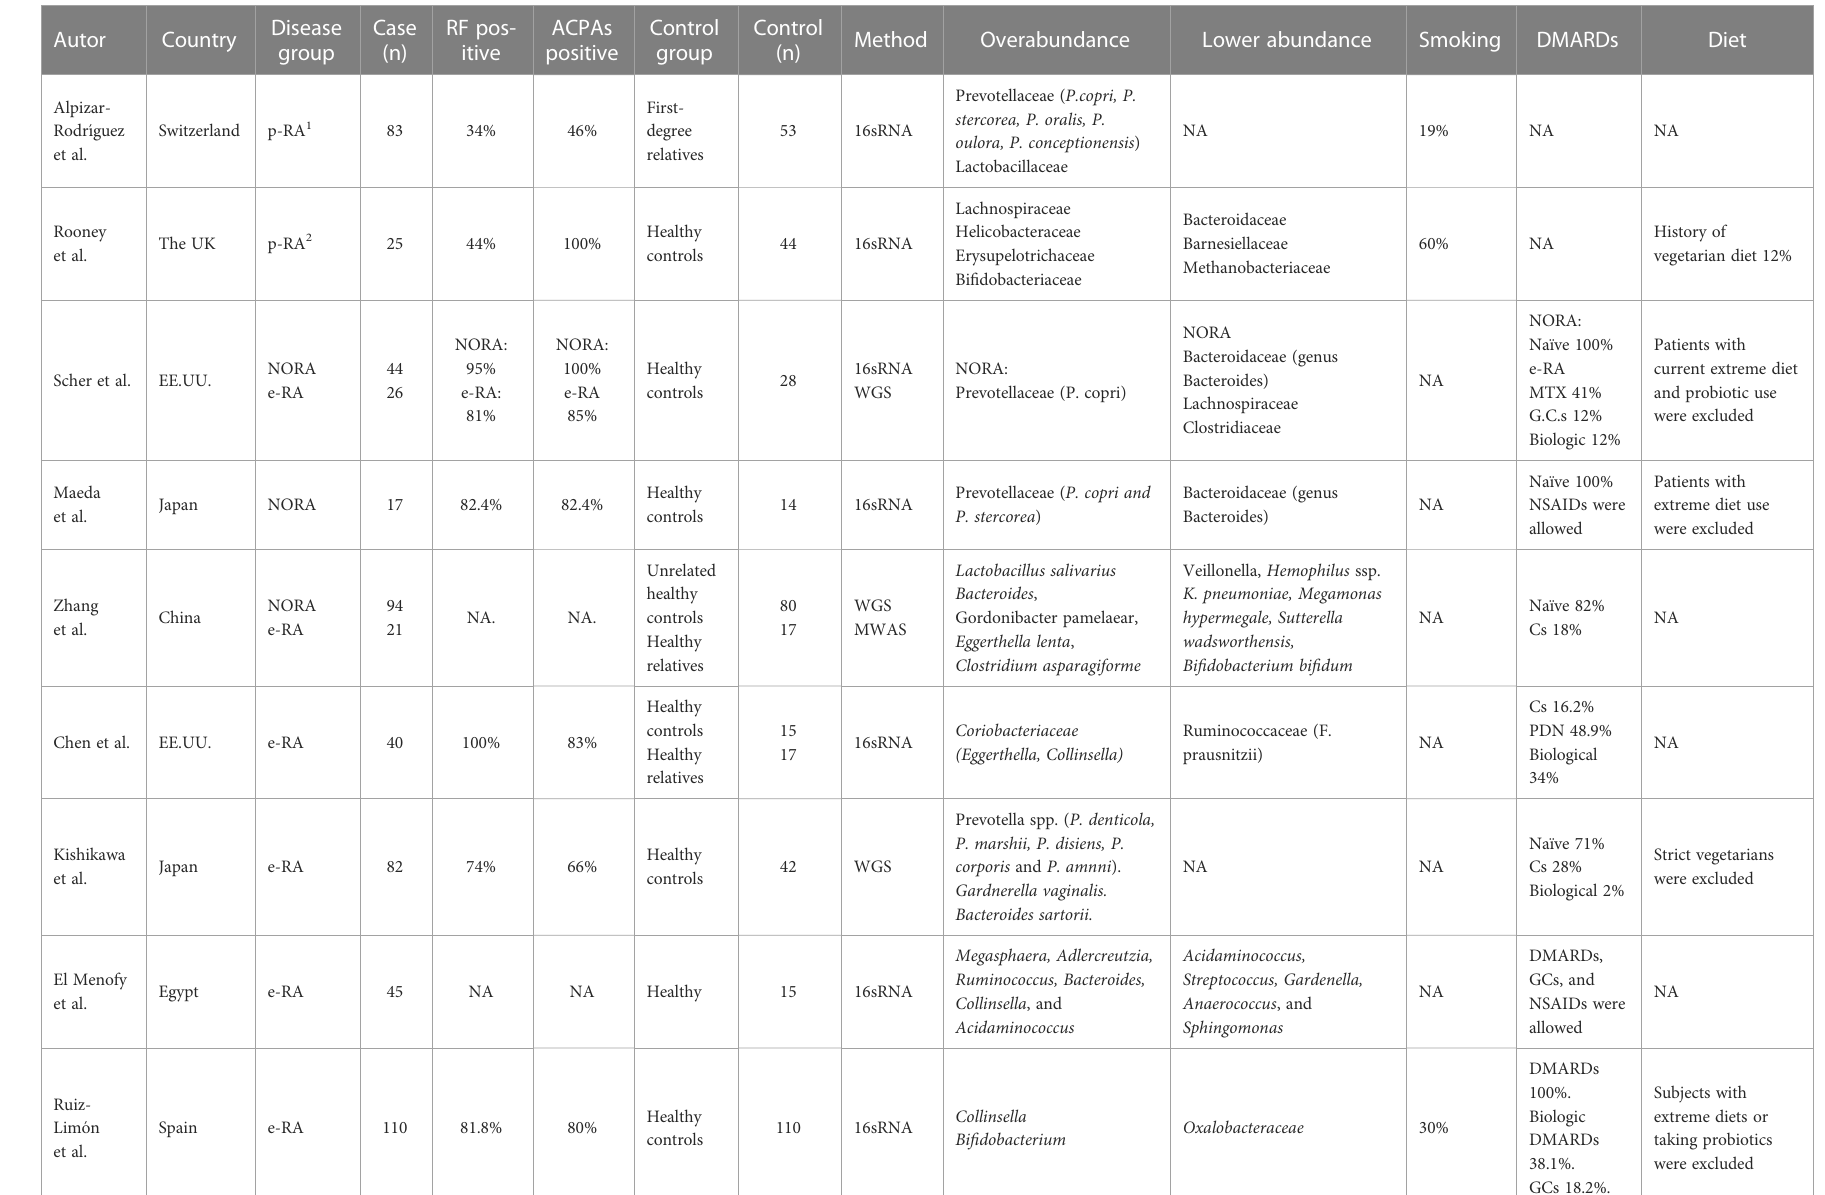
TABLE 1 Summary of studies evaluating the role of Gut Microbiota in Rheumatoid Arthritis